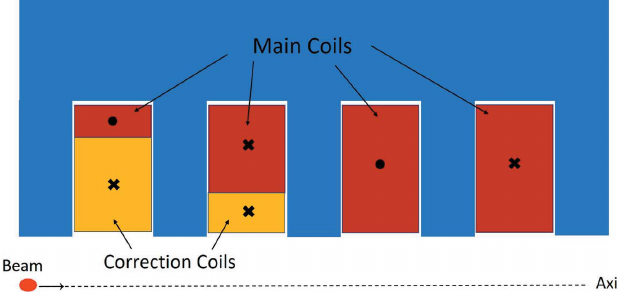
Figure 3 Winding configuration of the first four coils grooves on one core-end. The main coil packs (red rectangles) and the correction coil packs (yellow rectangles) are indicated in the figure. The directions of the coils are marked with dots and